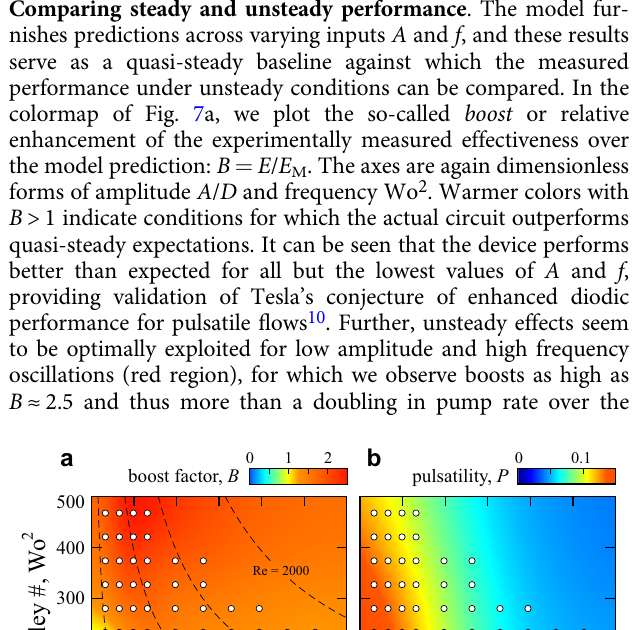
colormap of Fig. 7a, we plot the so-called boost or relative enhancement of the experimentally measured effectiveness over the model prediction: B = E / E M . The axes are again dimensionless forms of amplitude A / D and frequency Wo 2 . Warmer colors with